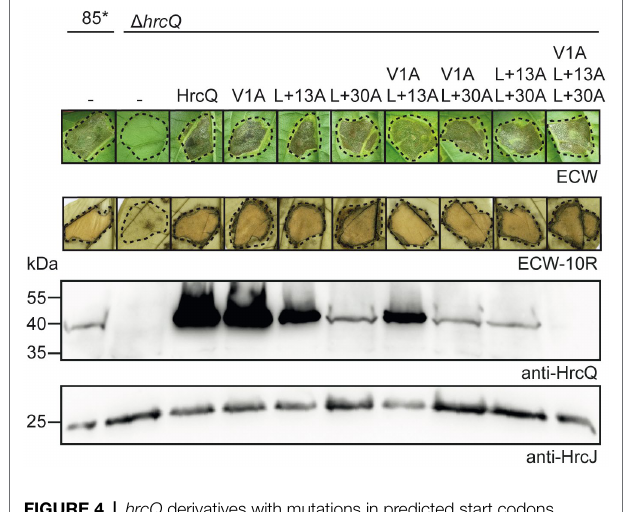
FIGURE 4 | hrcQ derivatives with mutations in predicted start codons restore pathogenicity in a hrcQ deletion mutant. Strains 85* and 85* ∆ hrcQ without plasmid ( − ) or containing expression constructs encoding HrcQ and mutant derivatives thereof with mutations in predicted start sites as indicated under control of the native promoter were infiltrated into leaves of susceptible ECW and resistant ECW-10R pepper plants. Dashed lines indicate the infiltrated areas. Disease symptoms were photographed 8 dpi. For the better visualization of the HR, leaves were bleached in ethanol 2 dpi. For protein analysis, equal amounts of cell extracts were analyzed by immunoblotting using HrcQ- and HrcJ-specific antibodies. Experiments were performed three times with similar results.